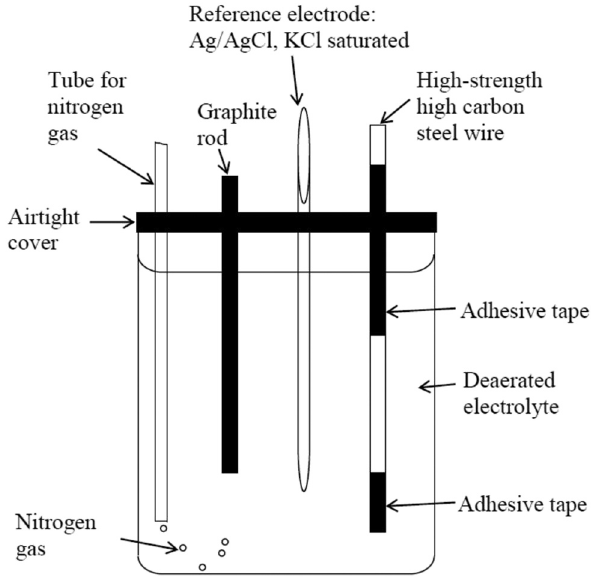
Figure 2: Schematic drawing of the electrochemical